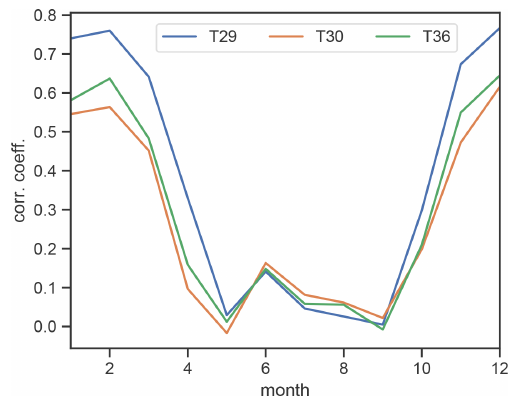
Figure 3. Monthly mean correlation of cave air temperature (T29, T30, T36) with external temperature ( T out